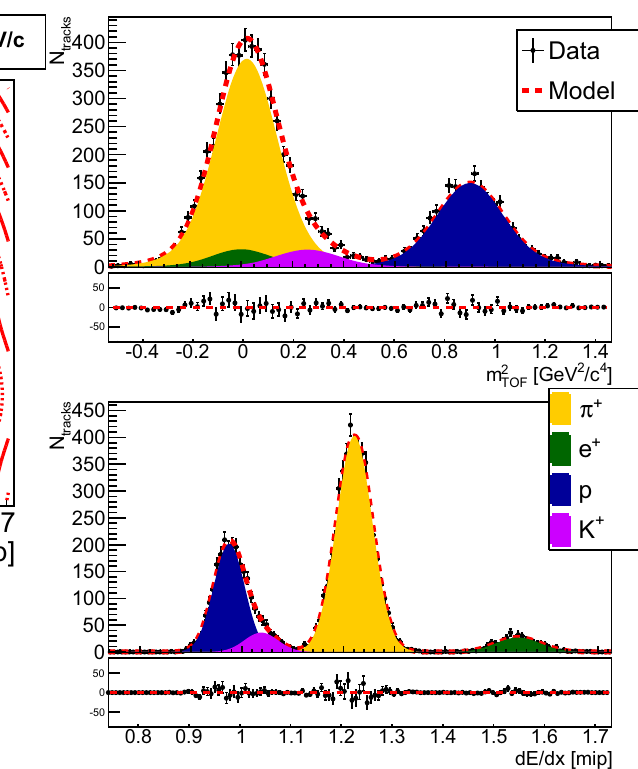
Fig. 14 An example of the joint m 2 - d E / d x fit for a single ( p ,θ, z ) the extracted number of π + , K + , p and e + . The top right and bottom tof bin. The top left panel shows the 2D distribution of the data with a right panels show projections of the data and fitted function to m 2 contour plot of the fitted function in red. The bottom left panel shows d E / d x axis, respectively